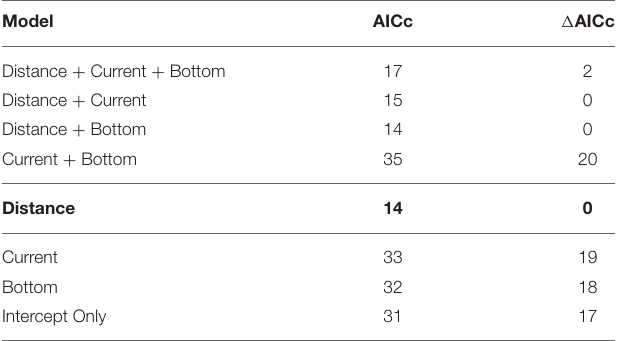
TABLE 2 | Comparative AICc model results for predicting some measureable impact or response on the surrounding environment of the offshore